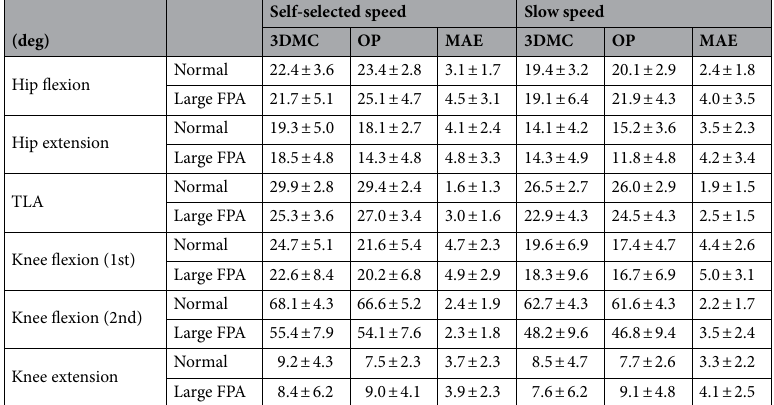
Table 2. Peak hip and knee joint angles during a gait cycle in the four gait conditions (mean ± SD). In large FPA condition, participants were instructed to walk with an FPA of 50°. OP and proposed methods used the same calculation. MAE was averaged after calculating the absolute value of the difference between each participant’s data measured by two methods.